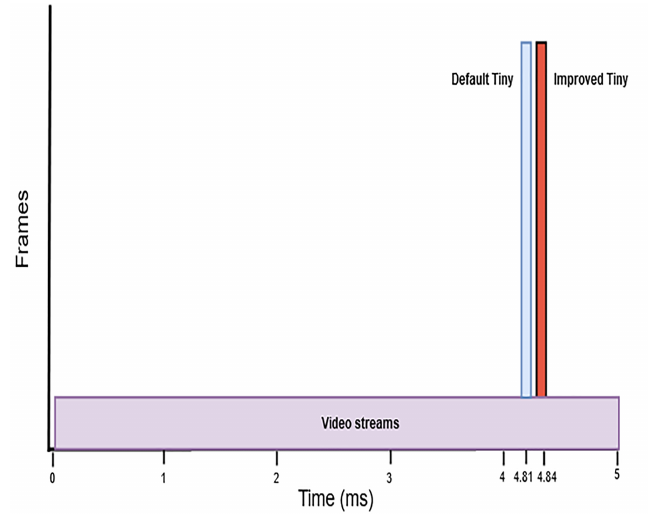
Figure 16. Detection time comparison of both models. Table 1. Parameters opted during training phase for both models.